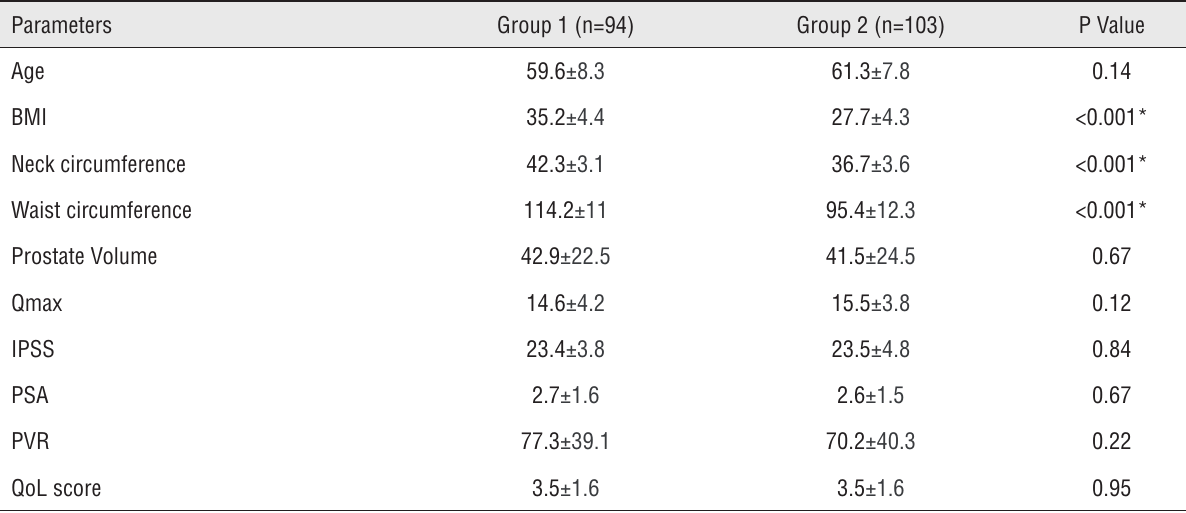
Table 2 - Comparison of baseline parameters in groups.